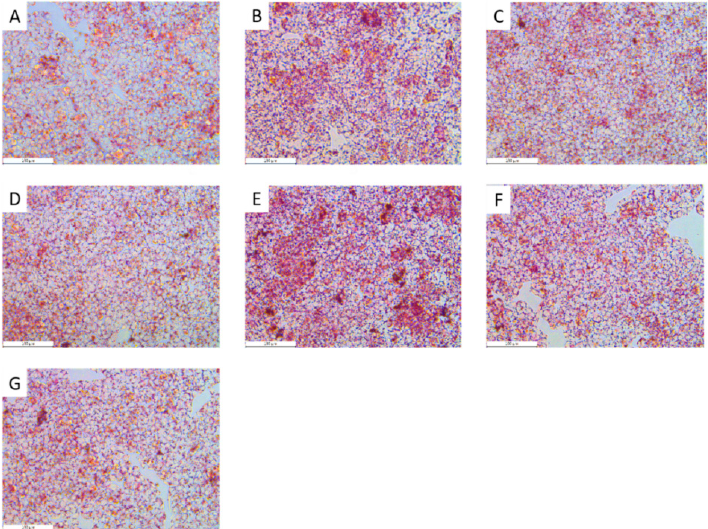
Figure 7. Effects of total flavonoids of MCB on fat accumulation in HepG2 cells (200×). ( A ) control group, ( B ) OA group, ( C ) OA + simvastatin (25 µM) group, ( D ) OA + MTF (200 µg/mL) group, ( E ) Compound C (10 µM) group, ( F ) simvastatin (25 µM) + Compound C (10 µM) group, ( G ) MTF (200 µg/mL) + Compound C (10 µM) group.